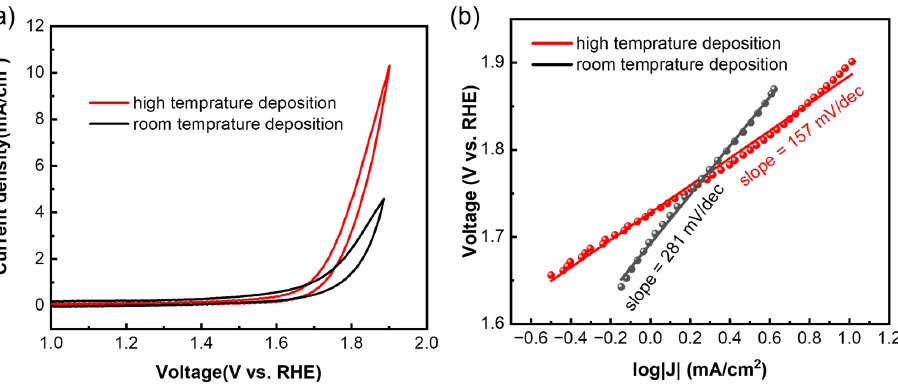
Figure 4. ( a ) Cyclic voltammetry test of Sb nanofilms deposited at different temperatures, and ( b ) corresponding Tafel slopes.